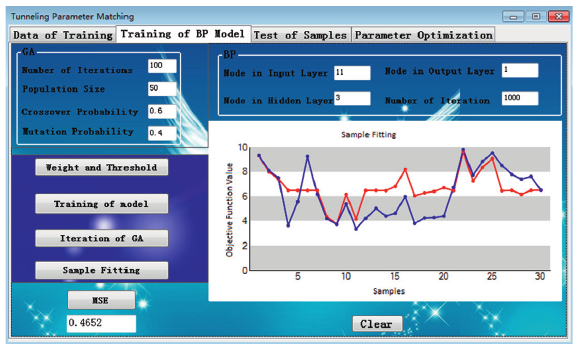
Figure 6: The interface of the BP model training.